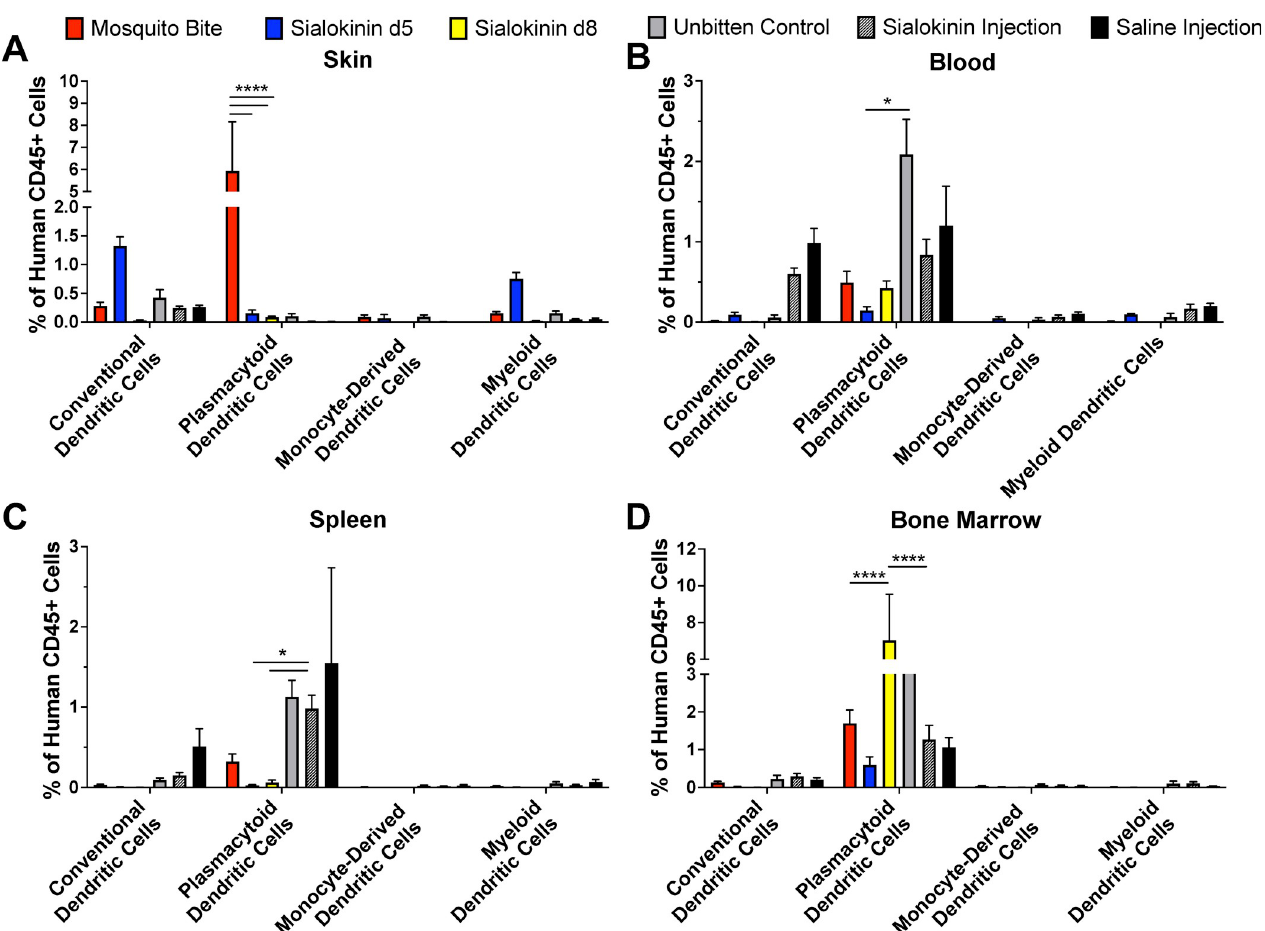
Fig 2. Sialokinin knockout mosquito bites alter levels of plasmacytoid dendritic cells in humanized mice. Hu-NSG mice were subjected to four bites each from sialokinin knockout mosquitoes and were euthanized 7 days postbite. Skin ( A ), blood ( B ), spleen ( C ), and bone marrow ( D ) were collected and changes in DC populations were assessed via flow cytometry. Mosquito Bite indicates mice bitten by wild-type mosquitoes, and Unbitten indicates mice that were not bitten by mosquitoes. Data are represented as the mean percentage of the cell population out of total human CD45+ cells. Error bars represent 1 SEM. Statistical significance was determined using two-way ANOVA followed by multiple comparison t-tests using the Holm-Sidak correction. The threshold for significance was p < 0.05. Asterisks indicate: � = p < 0.05; ���� = p < 0.001. Cell markers used to describe populations: Conventional dendritic cells: CD3-, CD19-, CD14-, CD123-, CD11c+; Plasmacytoid dendritic cells: CD3-, CD19-, CD14-, CD123+, CD11c-; Monocyte derived dendritic cells: CD3-, CD19-, CD14-, CD11b-, CD11c+, HLA-DR+; myeloid dendritic cells: CD3-, CD19-, CD14-, CD11b+, CD11c+.